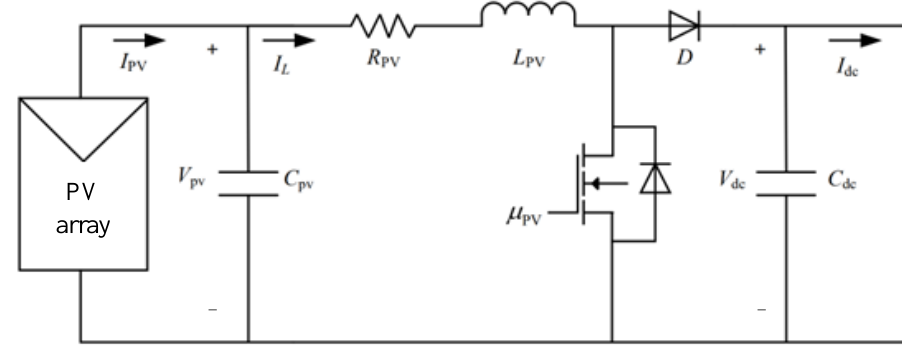
Figure 2. Equivalent circuit diagram of solar PV system and DC/DC boost converter.